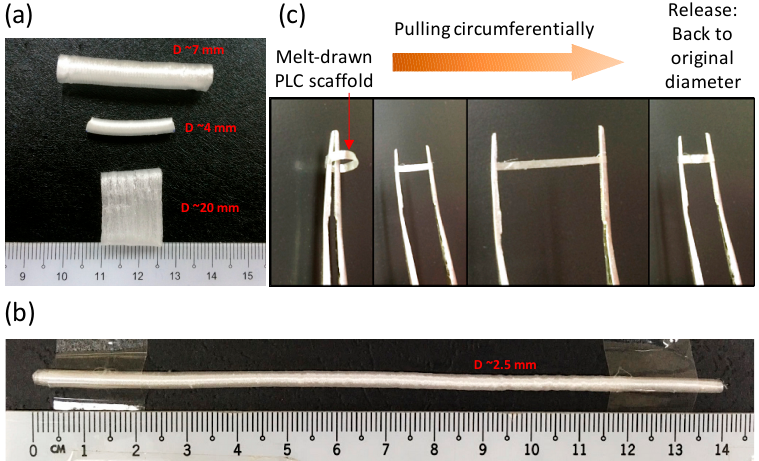
Figure 3. ( a , b ) Pictures of PLC scaffolds with different dimensions; ( c ) Illustration of elasticity of PLC scaffold in the radial direction.